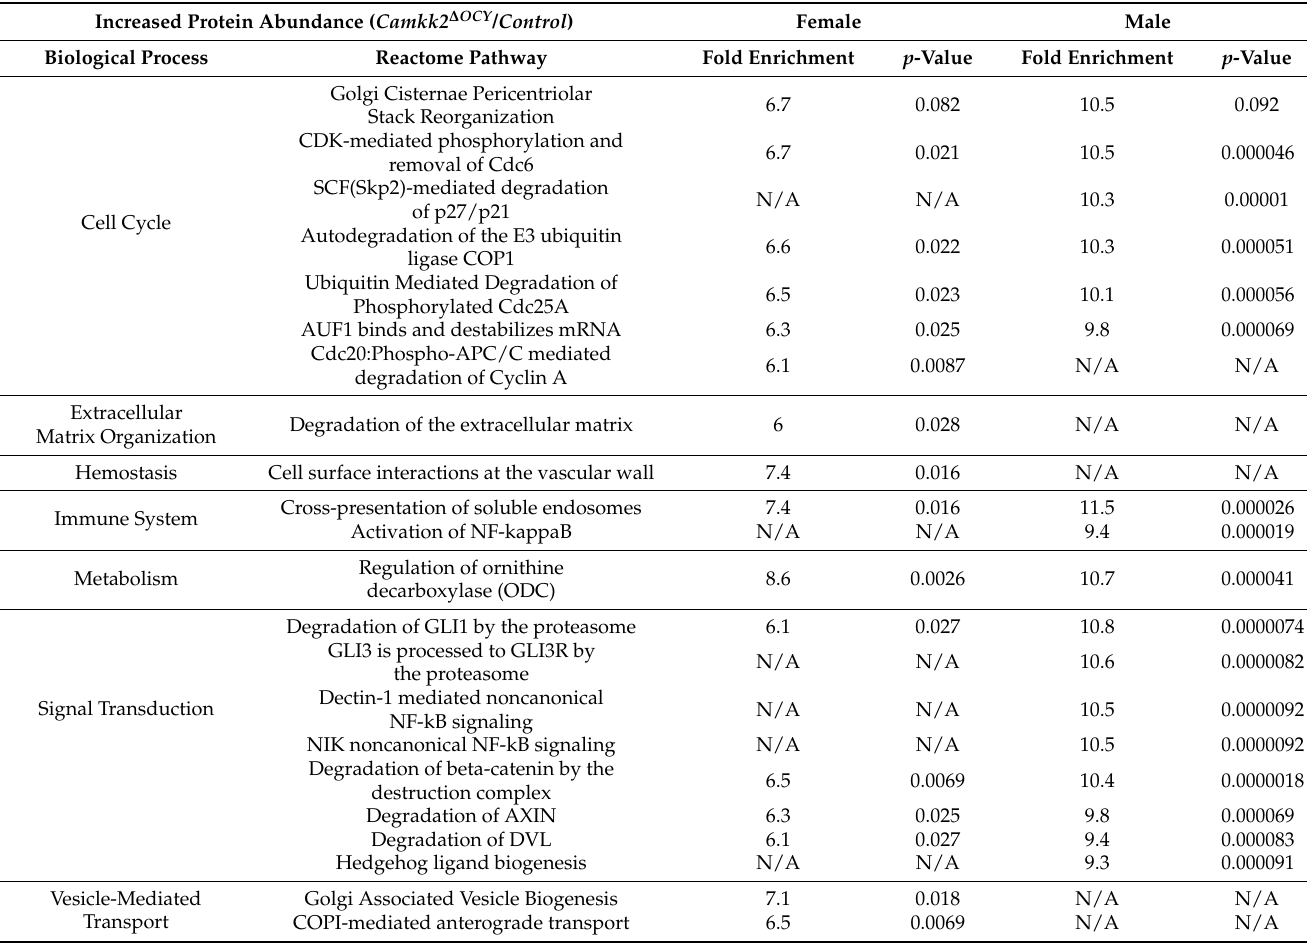
Table 1. Pathway Enrichment